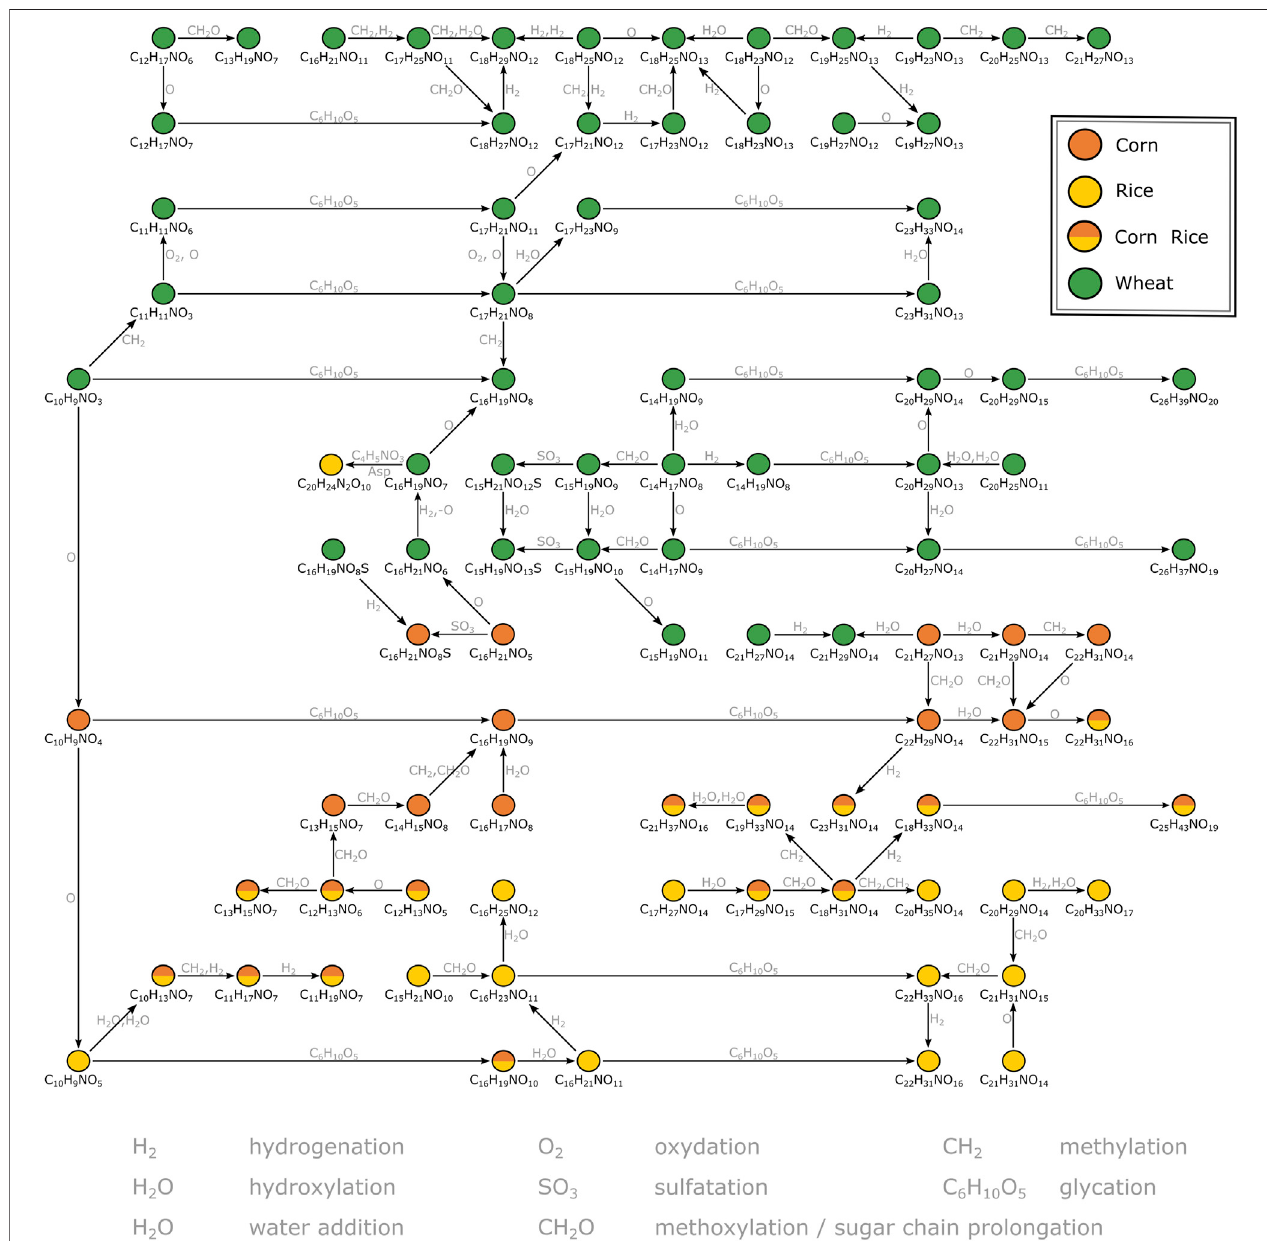
FIGURE3| Massdifferencenetworkexcerptofcompositionscharacteristicforwheat,cornandrice.Thenodesrepresentingannotationsareconnectedbyedges representing potential biochemical reactions. Some connections are neglected for reasons of clarity. The annotations likely correspond to secondary metabolites deriving from the indolacetic acid and benzoxazinone biosynthetic pathways respectively.